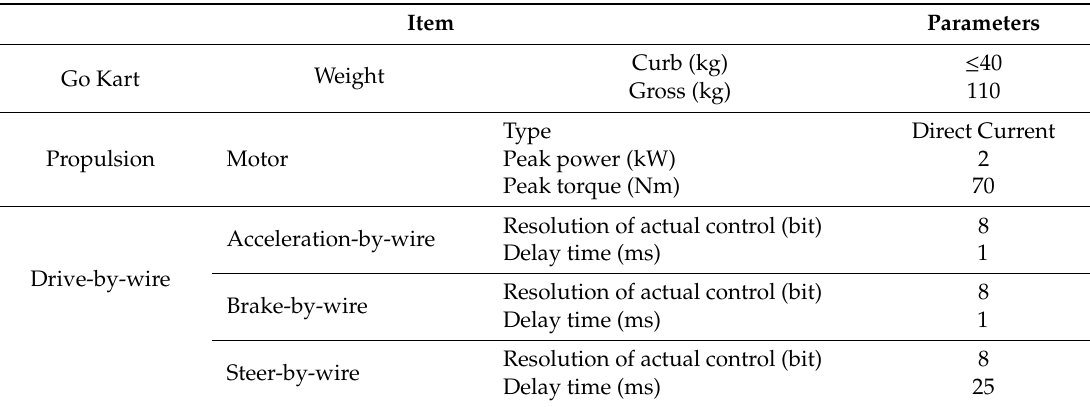
Figure 15. The system verification of drive-by-wire: ( a ) remote control to go straight; ( b ) remote control to turn left; ( c ) remote control to turn right under the passenger mode. Table 2. The main specifications of the go kart.